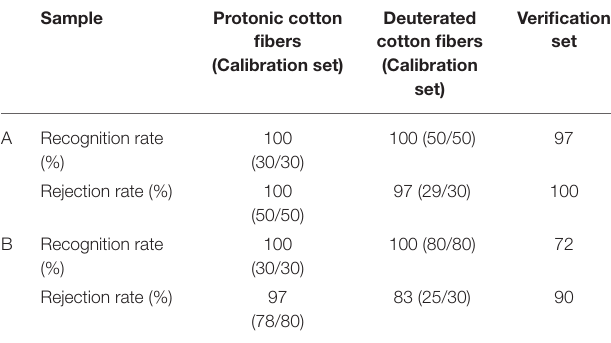
TABLE 3 | Classification result of soft independent modeling of class analogy (SMICA) models [A: high deuteration rate (20–60%) fibers and protonic fibers; B: high and low deuteration rate (1–60%) fibers and protonic fibers].